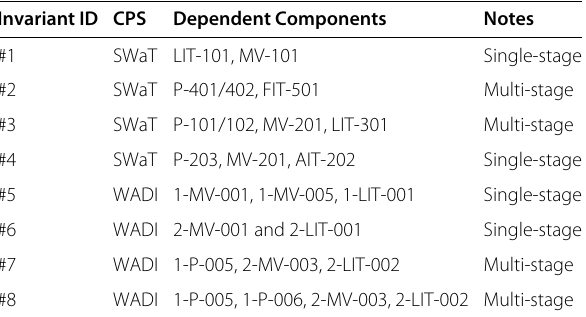
Table 10 Dependent sensors and actuators of some design-derived invariants for SWaT and